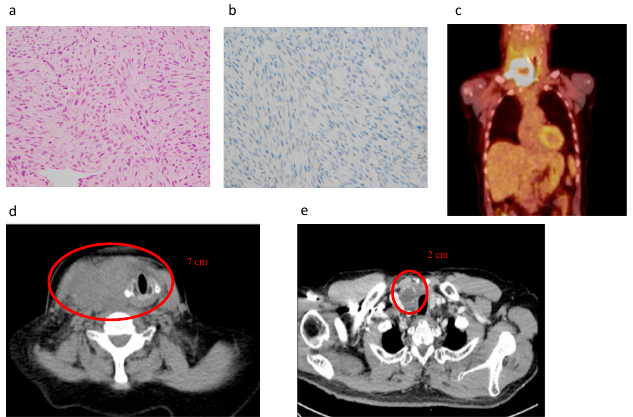
Figure 3. Histopathology and images of case report described in Box 1. ( a ) Haematoxylin and eosin stain of tumour, ( b ) BRAF V600E stain of tumour, ( c ) PET scan at initial presentation, ( d ) CT at initial presentation, ( e ) CT after one month of daily Lenvatinib 20mg treatment and 50Gy external beam radiation. Box 1. Case report.